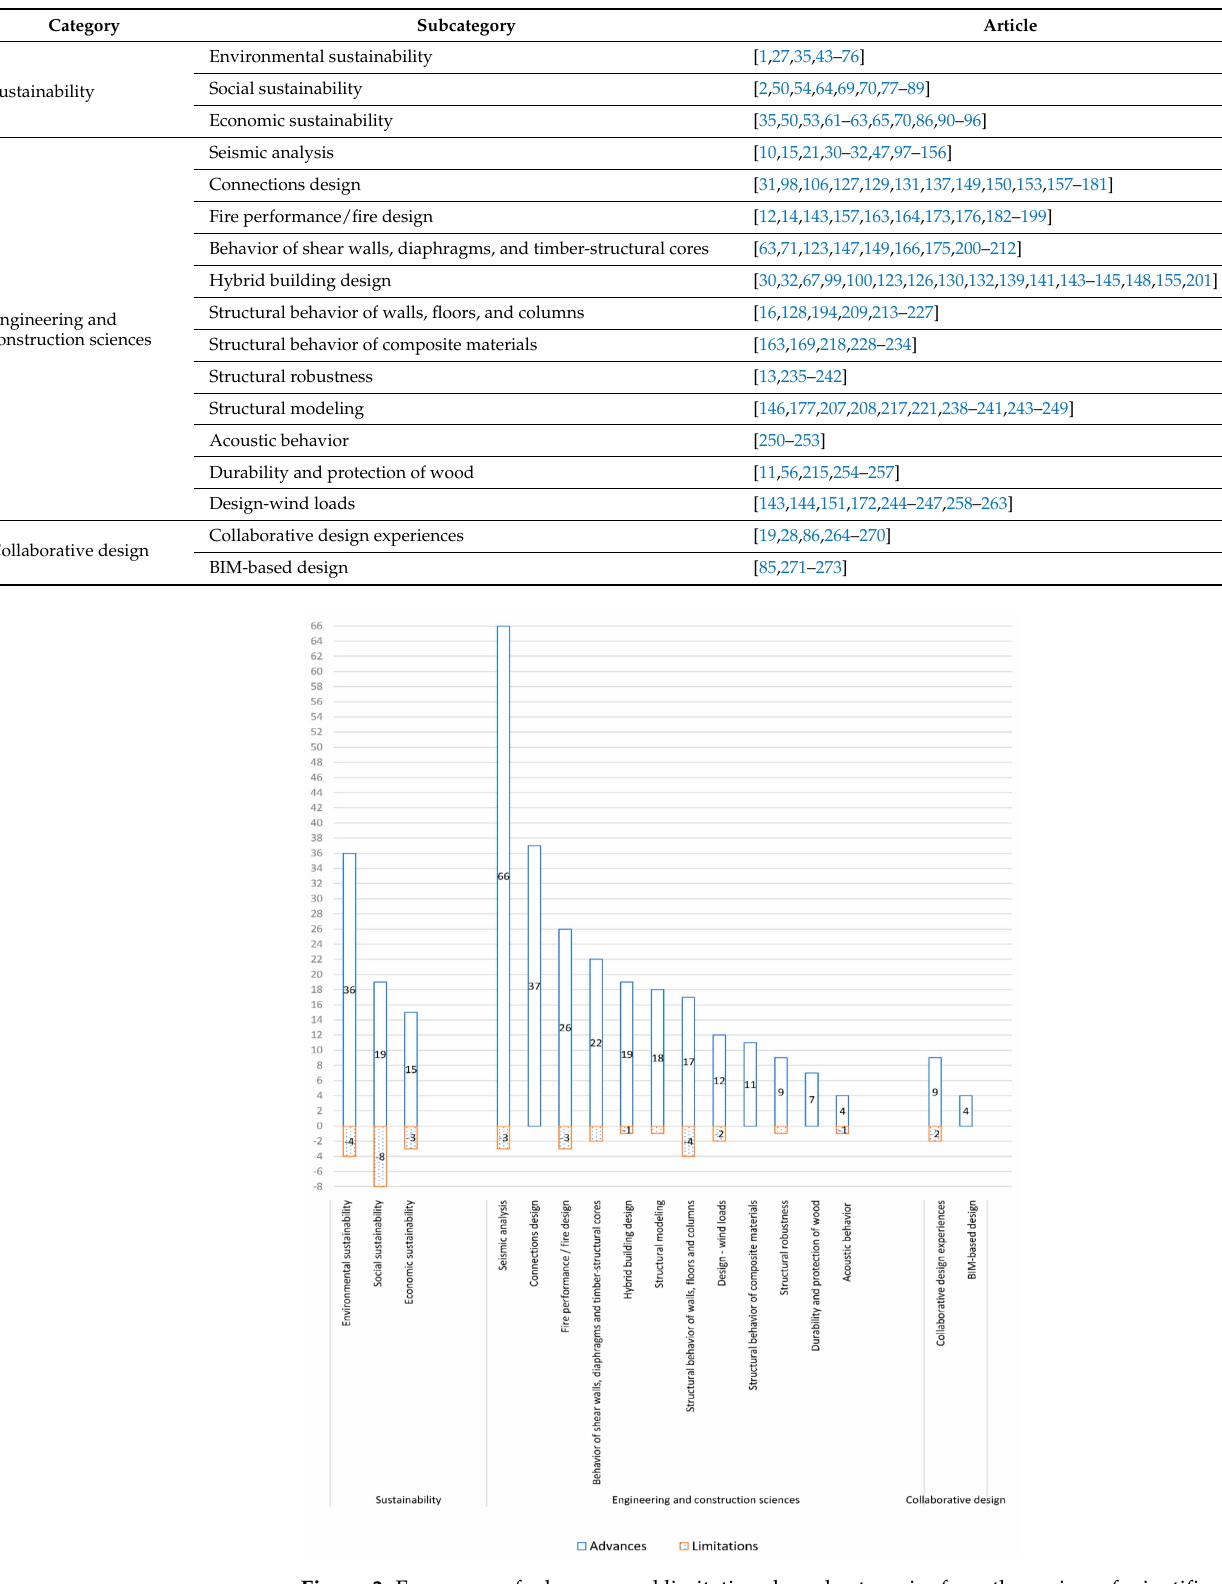
Figure 3. Frequency of advances and limitations by subcategories from the review of scientific articles on multi-storey timber